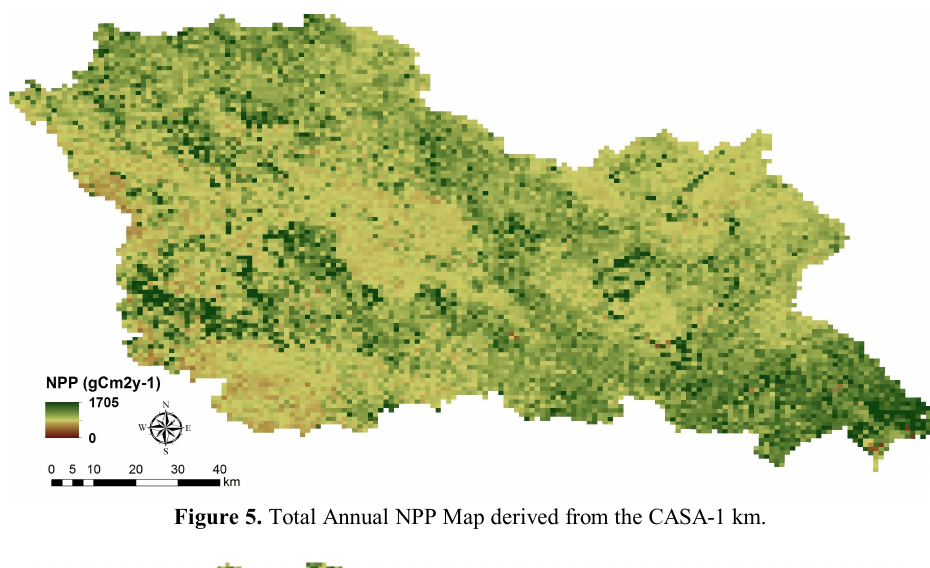
Figure 5. Total Annual NPP Map derived from the CASA-1 km.